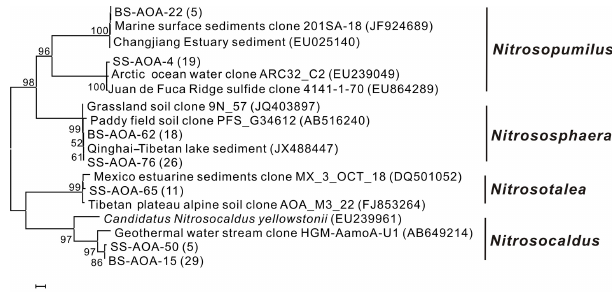
Figure 5. The phylogenetic tree of archaeal amoA genes is cloned from the Gongxiaoshe hot spring sediments (SS and BS). The tree is constructed using the neighbor-joining method, and bootstrap con- fidence values over 50% (1000 replicates) are shown. The scale bar represents the expected number of changes per nucleotide